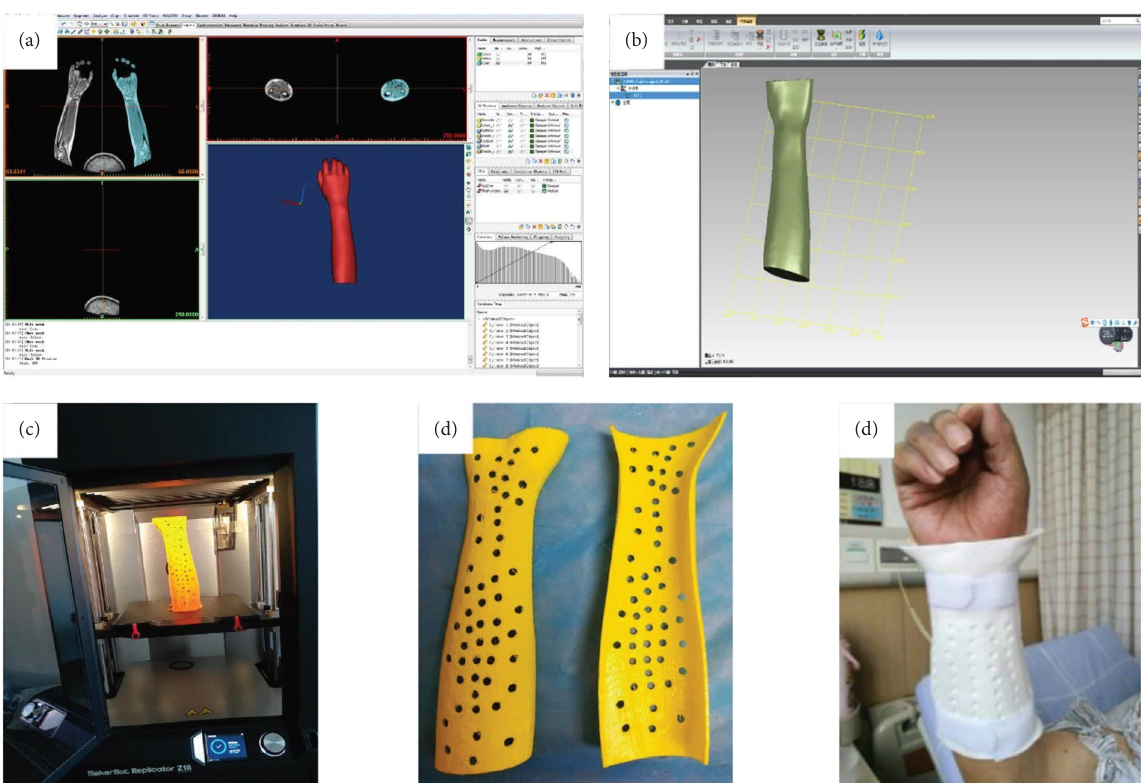
Figure 20: (a) 3D reconstruction of forearm and hand structures. (b) Processing and entity modeling of 3D model of the orthosis. (c) 3D printing. (d) 3D printing physical model. (e) 3D printed right